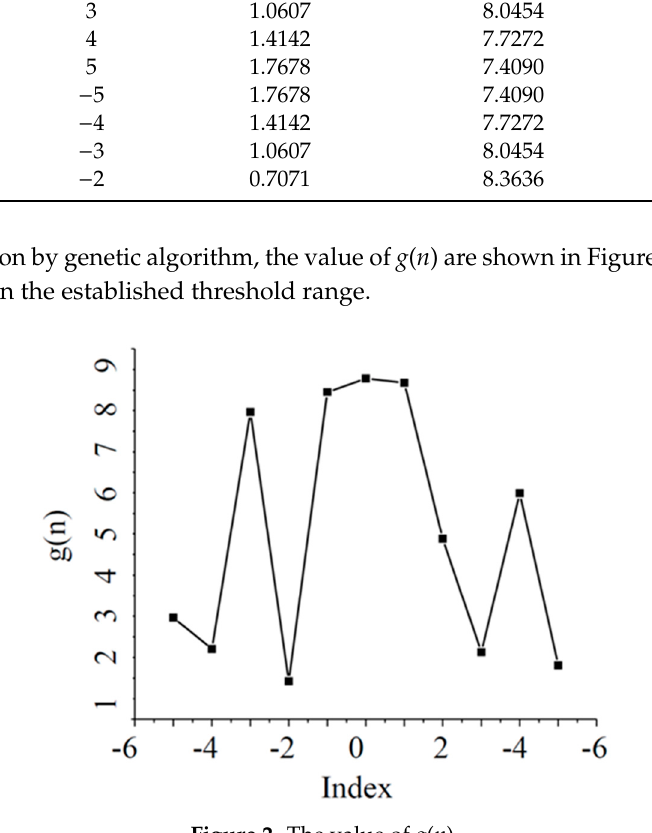
Figure 2. The value of g ( n ).